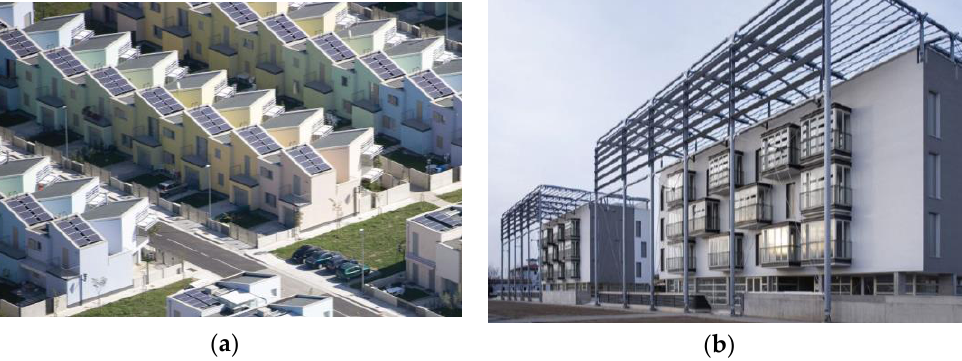
Figure 11. ( a ) Aerial view of the terraced houses of Violino District (source: © BAMSphoto — Basilio) and ( b ) the two multi-family houses (photo: © Fabio Cattabiani).